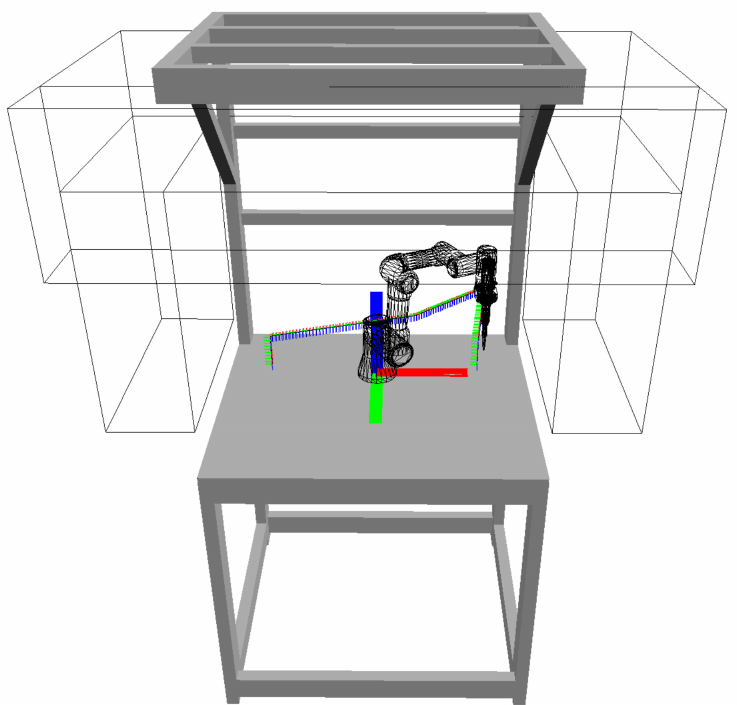
Figure 14. Visualization of the space available for camera placement (gray bounding